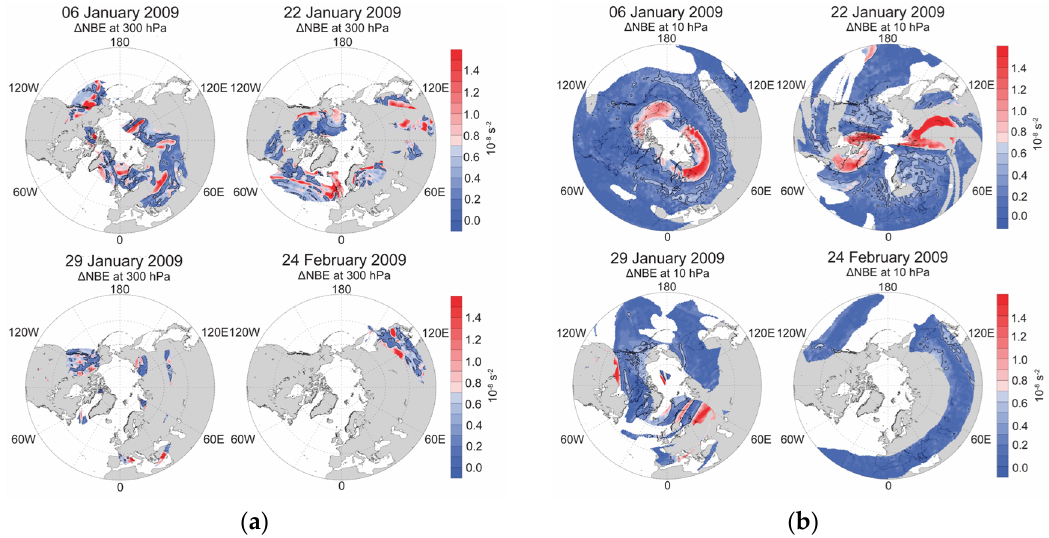
Figure 9. MERRA unfiltered ∆ NBE plotted in false color for four days in January and February 2009 at ( a ) 300 hPa (~9 km) and ( b ) 10 hPa (~31 km). The solid line is the 0.4 × 10 − 8 s − 2 contour.